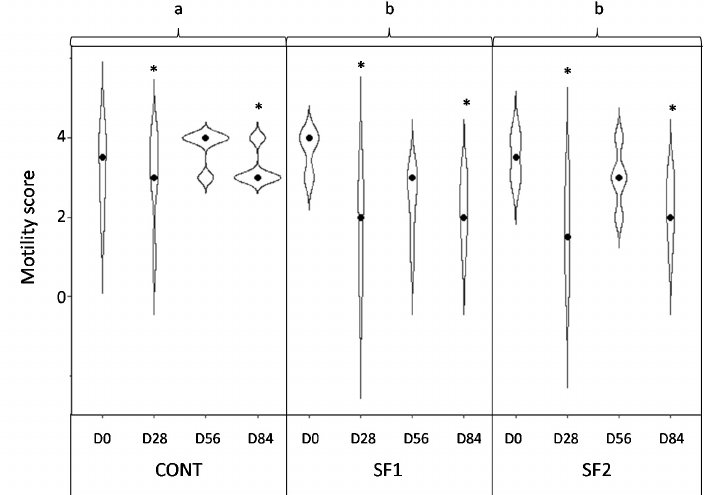
Figure 4. Violin plot representing the changes in larval motility score in naturally infected horses fed a control diet (CONT), a diet providing 1.53 g (SF1) or 3.06 g (SF2) DM pelleted sainfoin/kg BW/day (dots represent median values). a, b: different letters indicate significant differences between diets. * p < 0.05 compared to the motility at D0.